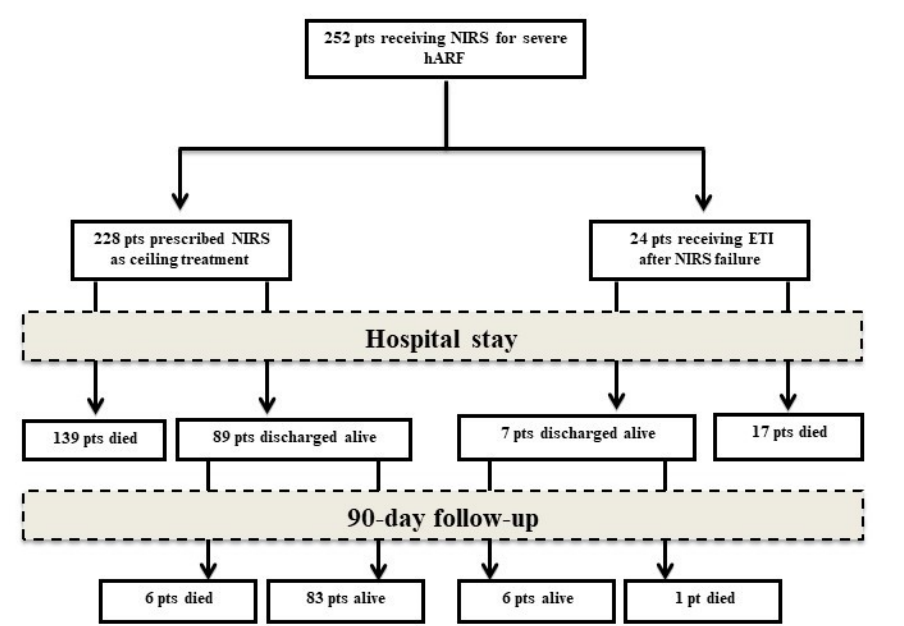
Figure 1. Study profile. NIRS, non-invasive respiratory support; ETI, endotracheal intubation. Table 2 outlines the HRs for the association between the patients’ characteristics and the risk of 90-day mortality according to univariable Cox models. Older age, increasing CRP, SOFA score, and level of dependence were all associated with a statistically significant increased risk of death at 90 days, whilst higher levels of SaO 2 and longer duration of MV were associated with a decreased risk of death. Table 2. Distribution of patient characteristics according to death status at 90 days after hospitalization and hazard ratio (HR) and 95% confidence interval (95%CI) derived from the univariable Cox proportional hazard model.